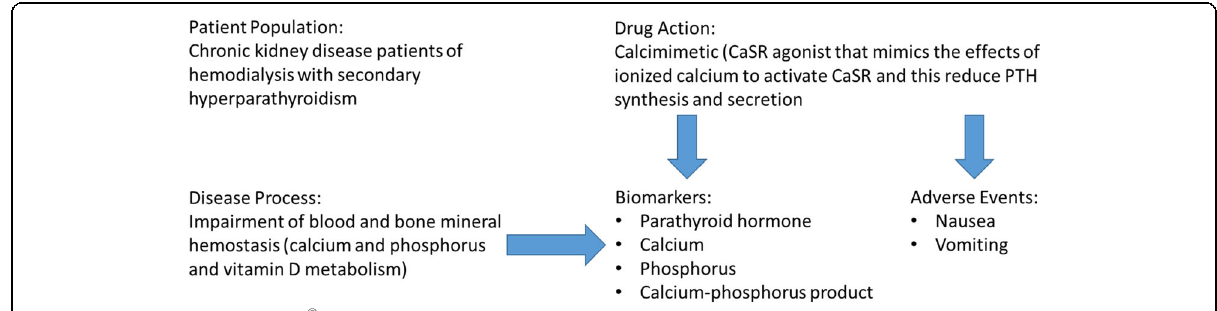
Fig. 1 Disease Model for the NVSA ©